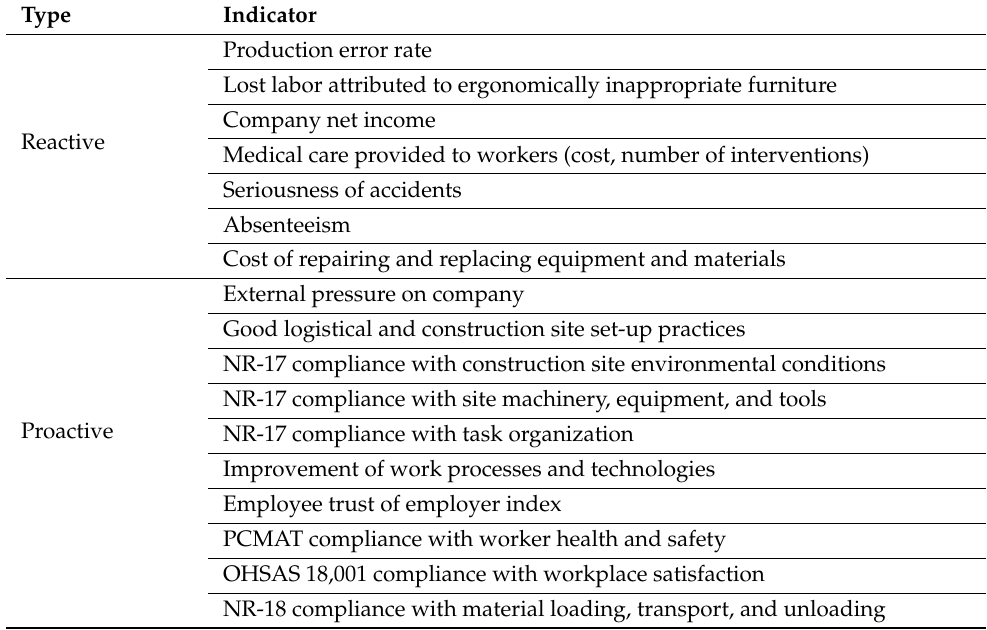
Table 6. Indicators used in the SIDECE system [21].